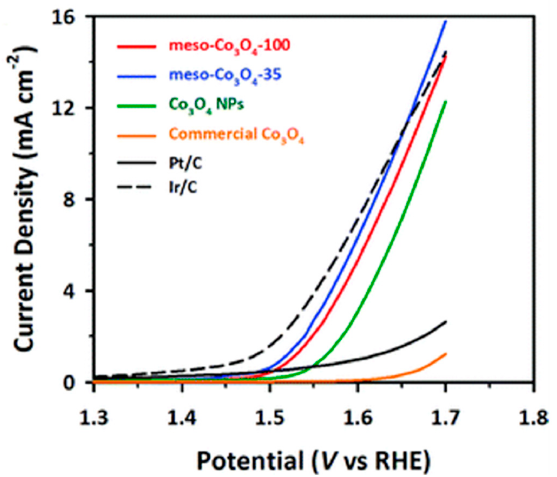
Figure 5. OER polarization curves for meso-Co 3 O 4 -100, meso-Co 3 O 4 -35, Co 3 O 4 NPs,